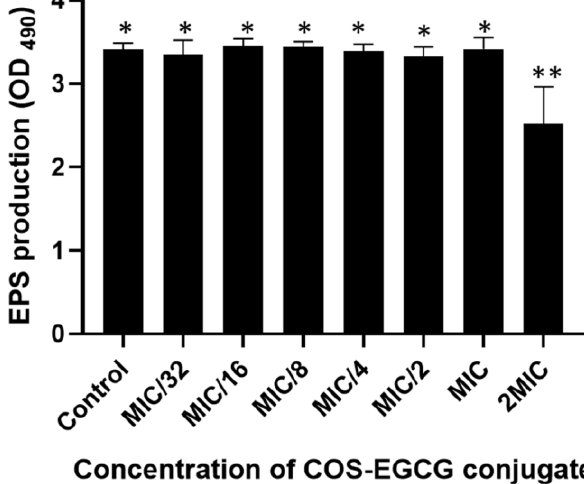
Figure 1. Extracellular polysaccharide production of L. monocytogenes F2365 treated with COS-EGCG at various concentrations in comparison with the control. The different asterisks on the bars denote significant differences ( p < 0.05). The results are presented as means ± SD ( n = 3).